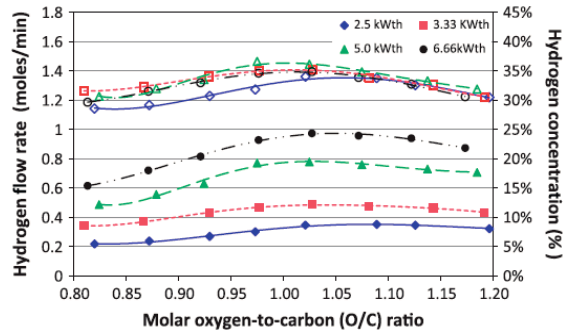
Figure 22. Hydrogen production concentration at various thermal power ratings, and a steam/carbon ratio of 2.0. Open symbols represent concentrations while closed symbols represent flow rates